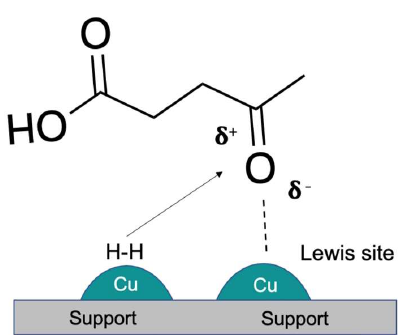
Figure 1. C=O activation over a copper catalyst prepared by CH.